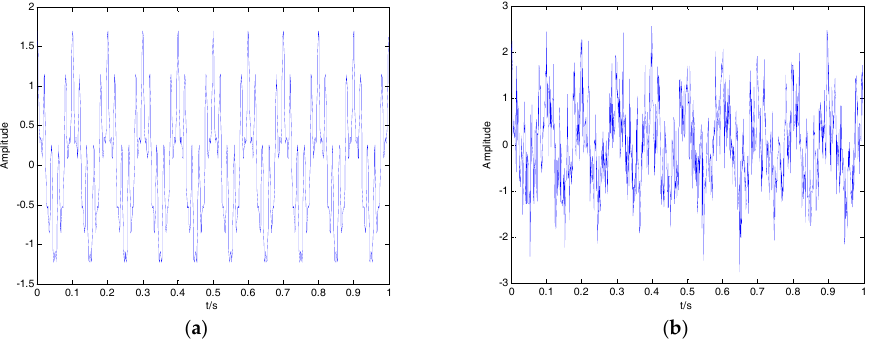
Figure 4. ( a ) The clear signal; ( b ) the noisy signal.